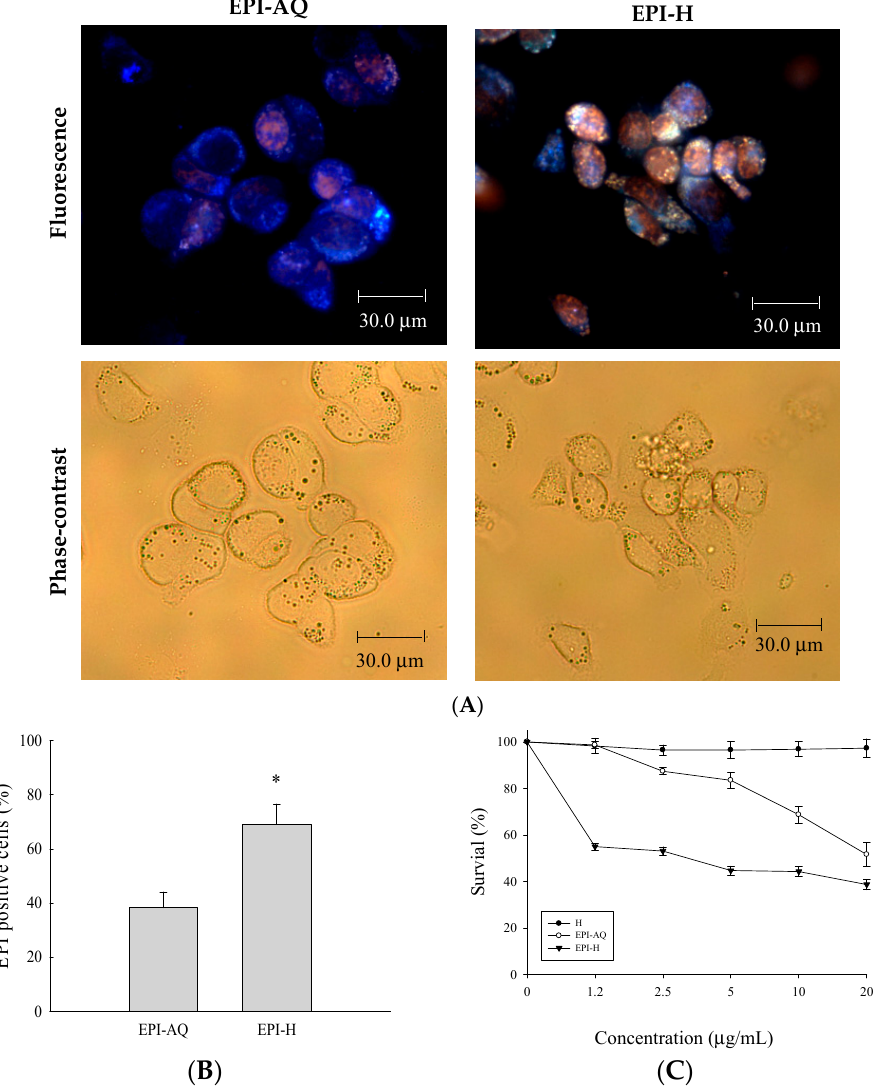
Figure 2. Epirubicin accumulated in AY-27 cells and induced cytotoxicity. ( A ) Fluorescent images of epirubicin (red) and DAPI (nuclei, blue), with phase-contrast images of AY-27 cells after EPI-AQ and EPI-H treatment for 18 h. (magnification, ×400) ( B ) The statistics of epirubicin-positive cells in the EPI-AQ and EPI-H treatment AY-27 cells; ( C ) The cytotoxicity of AY-27 cells with H, EPI-AQ, and EPI-H treatment for 18 h prior to the MTS assay. All results are expressed as the mean ± standard error of four independent experiments. * p < 0.05 in cases of EPI-H versus EPI-AQ.